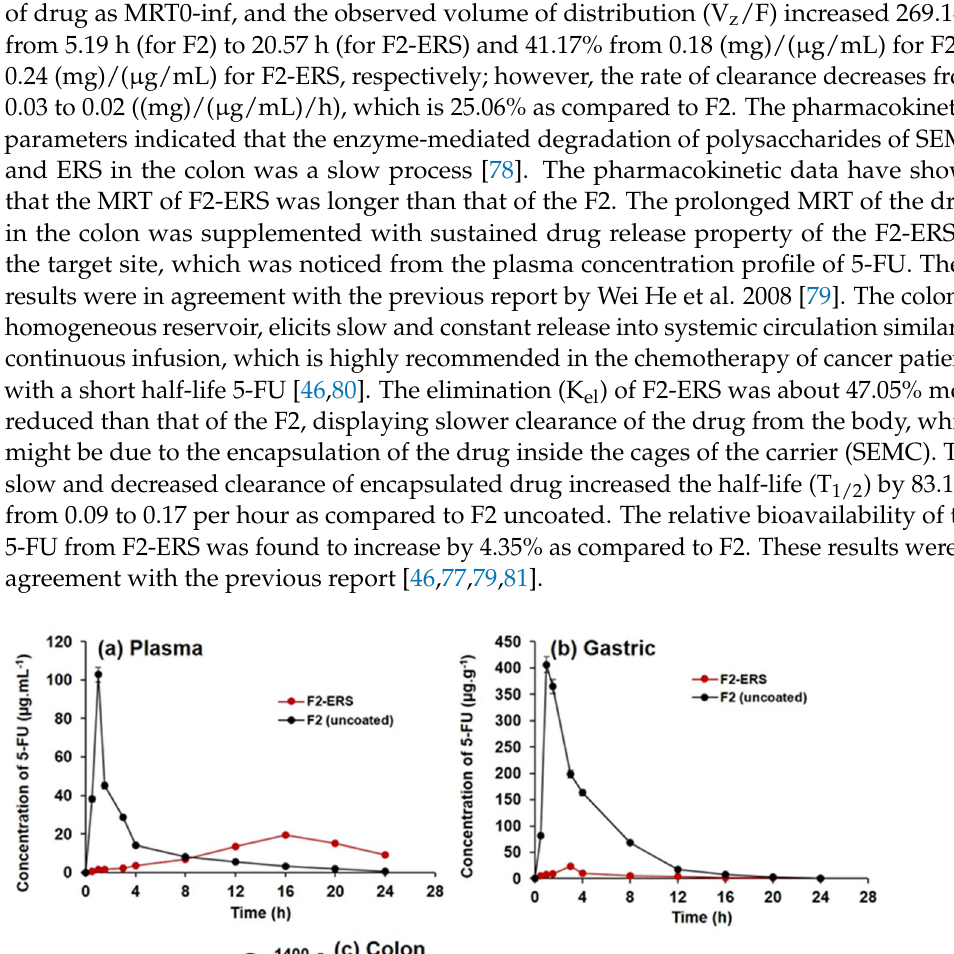
The distribution of 5 ‐ FU into the stomach and small intestine after the administration of colon ‐ directed F2 ‐ ERS and F2 is represented in Figures 5b . The mean peak concentra ‐ tions of 5 ‐ FU in the tissues of the stomach and small intestine from F2 were 406.2 ± 15.04 μ g/g at 1 h, 198.6 ± 6.9 μ g/g at 3 h, 163.5 ± 5.6 μ g/g at 4 h, and 16.9 ± 1.7 μ g/g at 12 h. These data indicated that F2 was an immediate release formulation where a large quantity of 5 ‐ FU gets released in the upper part of the GI tract and small intestine. The pharmacokinetic data of gastric tissue and small intestine of F2 ‐ ERS exhibit a reduction in Cmax ( μ g/mL), AUC0 ‐ t ( μ g/mL*h), and Ke (1/h) that is 94.20%, 92.96%, and 785.71%, respectively as compared to the F2 uncoated formulation and increased in half ‐ life (t 1/2 ), Tmax (h), MRT0 ‐ inf (h), Vz/F (mg)/( μ g/mL), and Cl/F {(mg)/( μ g/mL)/h} that is 352.71%, 200%, 142.14%, 5732.52%, and 1140%m respectively as compared to the F2 (uncoated) formulation indicating that a negli ‐ gible amount of 5 ‐ FU was released in gastric tissues and small intestine from the colon ‐ di ‐ rected F2 ‐ ERS and that the ERS coating remained intact during the transit of the SEMC through the stomach and small intestine. A sharp decrease in the concentration of 5 ‐ FU was found with F2, which might be attributed to the processes of absorption, systemic distri ‐ bution, and further movement toward the region of the small intestine. 3.12. Tissue Distribution of 5 FU in Colon Tissues The distribution of 5 ‐ FU into the colon tissues after administration of the F2 and F2 ‐ ERS are represented in Figure 5c. Significant differences in 5 ‐ FU concentrations in colon tissues were observed after administration of the two formulations ( p < 0.005). Pharmaco ‐ kinetic parameters of F2 ‐ ERS display a significant drastic increase in Cmax ( μ g/mL), AUC0 ‐ t ( μ g/mL*h), and Ke (1/h), that is 26,896.39%, 24,890.82%, and 200% respectively and decreased in half ‐ life (t 1/2 ), MRT0 ‐ inf (h), Vz/F (mg)/( μ g/mL), and Cl/F {(mg)/( μ g/mL)/h} that is 65.97%, 12.15%, 99.79%, and 99.01%, respectively as compared to F2 (uncoated) formulation. The maximum 5 ‐ FU concentration (C max ) from F2 ‐ ERS in colon tissues was 1271.5 ± 47.09 μ g/g at 12 h, following 1001.5 ± 37.09 μ g/g at 16 h, 650.4 ± 24.08 μ g/g at 20 h, and 90.4 ± 3.34 μ g/g at 24 h, respectively. Meanwhile, F2 releases a negligible